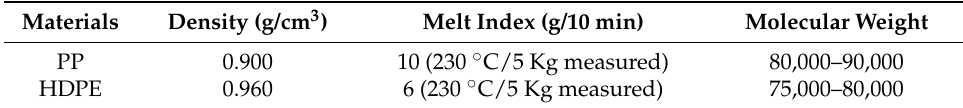
Table 2. Physical properties of the two